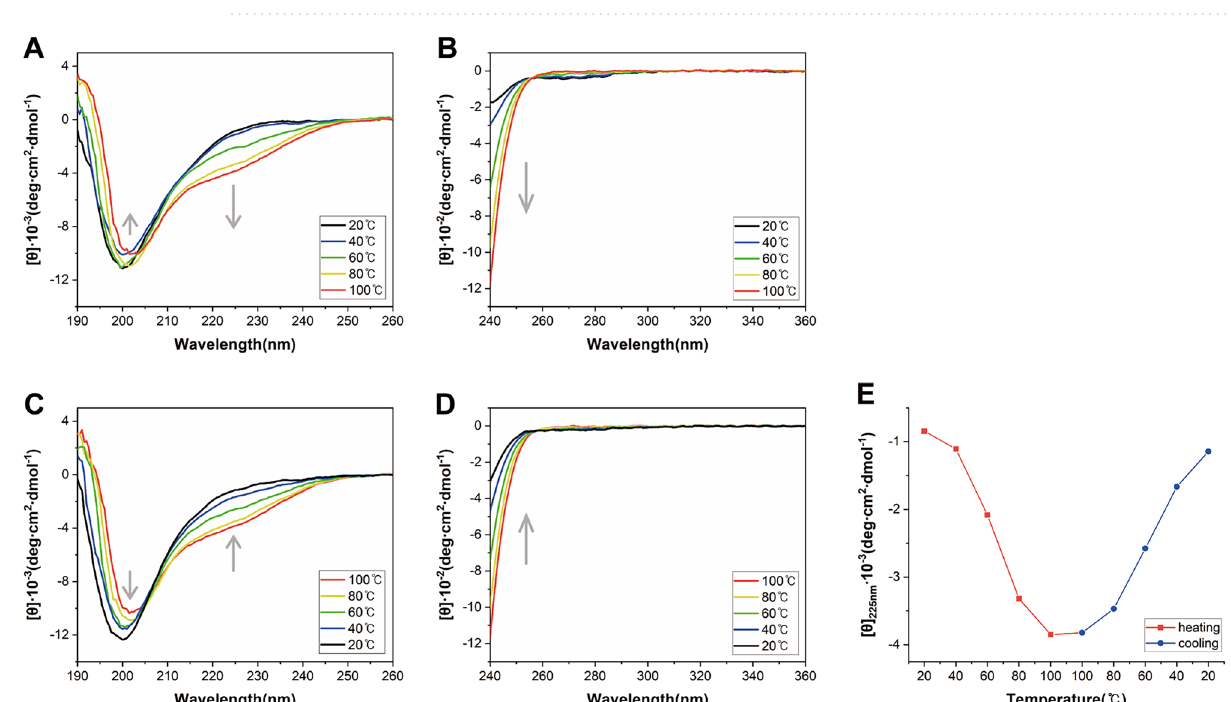
Figure 2. Temperature-dependent CD spectra of the wild type FGF21. Far-UV CD spectra upon heating ( A ) and cooling ( C ), and near-UV CD spectra upon heating ( B ) and cooling ( D ). Profiles at different temperatures are represented using different colored lines as shown in the right box of the figure. Gray arrows indicate the directions of spectral changes during heating and cooling. ( E ) The molar ellipticity [θ] values as temperature increases and decreases are colored in red and blue, respectively. For this figure, [θ] of FGF21 at 225 nm was used since far-UV CD spectral changes were dramatic at this